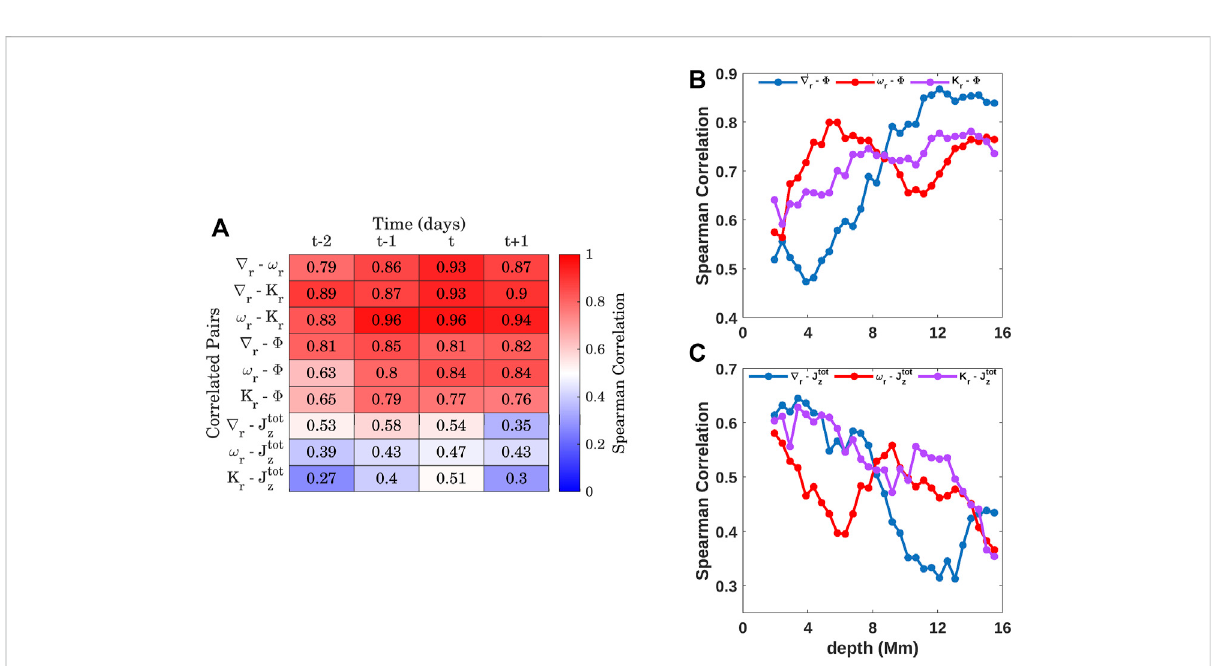
FIGURE 6 (A) Spearman correlation coef fi cients between the integrated horizontal fl ow divergence ( ∇ r ), vertical vorticity ( ω r ), kinetic helicity (K r ), surface magnetic fi eld ( Φ ) and total unsigned photospheric current helicity ( J tot z ) of active regions 2 days prior to (t-2), 1 day prior to (t-1), on the day (t) and 1 dayafter(t+1)the fl are.Colorbarrepresentsthestrengthofcorrelationsandallthevalues > 0 . 45havesigni fi cance > 95 % .The fl owparametersare averagedover2 – 15.5 Mm. (B) Spearmancorrelationbetweentheintegrated fl owparametersonthedayof fl arewiththecorrespondingsurface magnetic fl ux. (C) Spearmancorrelationbetweentheintegrated fl owparametersonthedayof fl areandtotalunsignedphotosphericcurrenthelicity. All the correlation coef fi cients in (B) and (C) have signi fi cance > 95 %